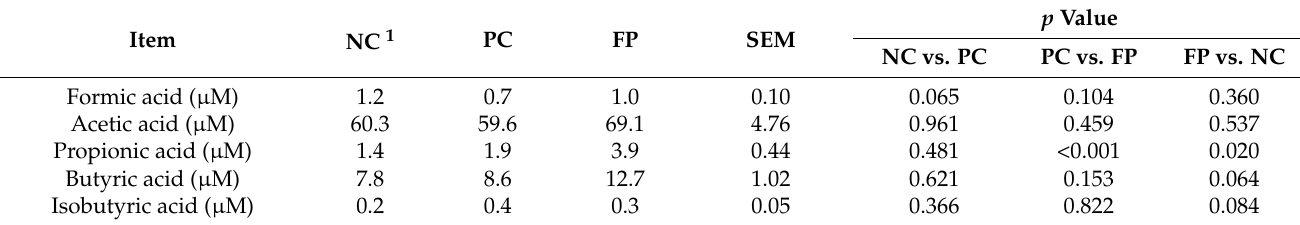
Table 3. Effect of fermented products produced by B. licheniformis on the cecal short-chain fatty acid levels of broilers in response to the coccidial